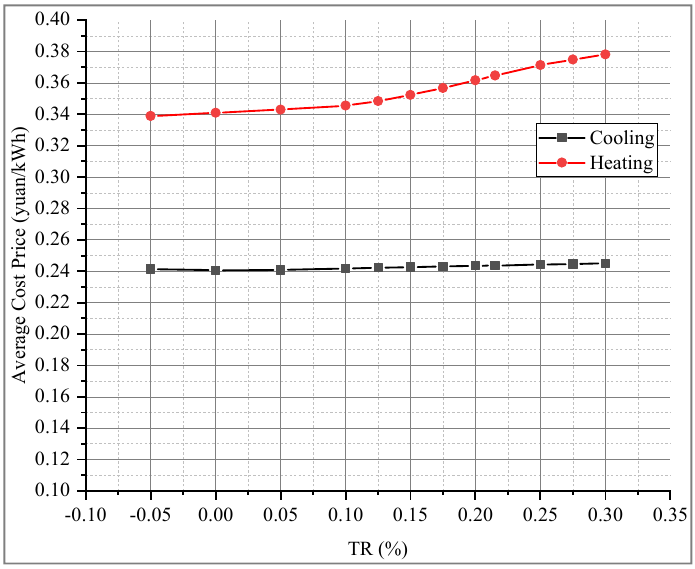
Figure 10. Flow chart of Algorithm (3). Appl. Sci. 2020 , 10 , 1565